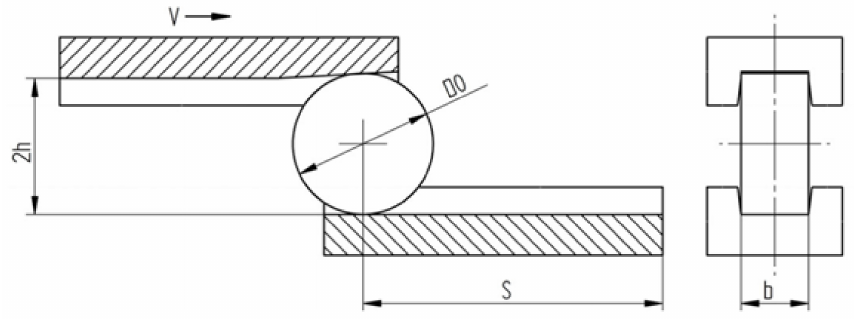
Figure 3. Scheme of the process of compression in a channel [58].